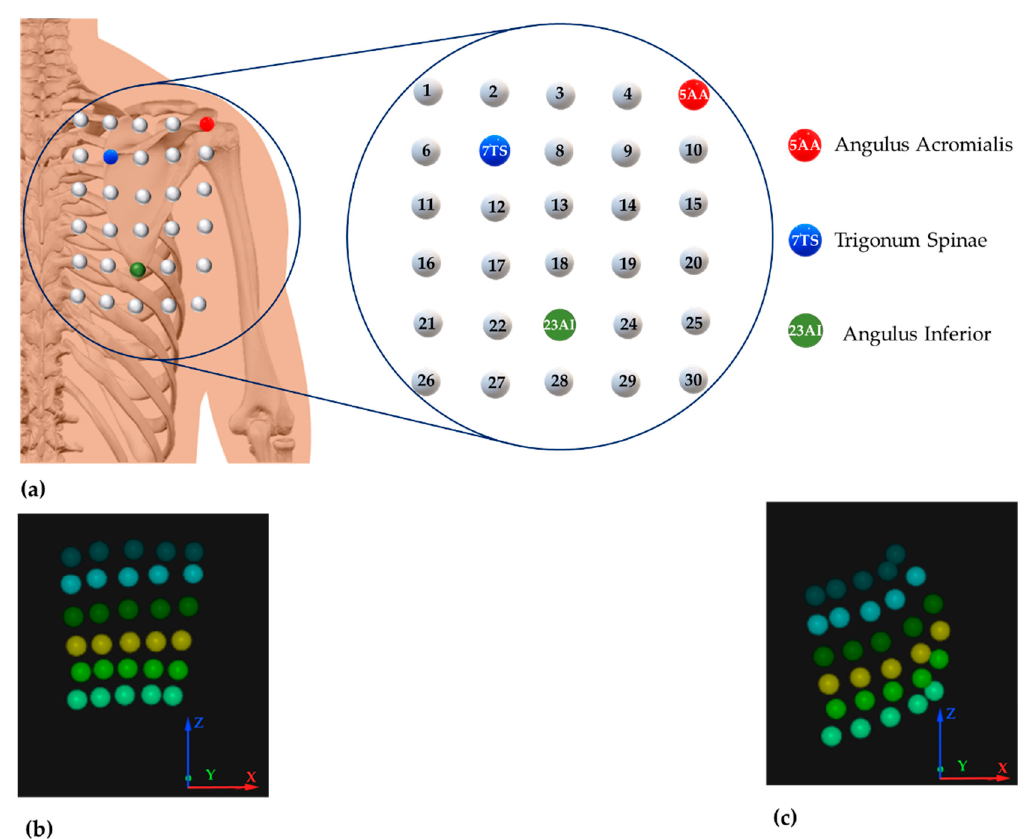
Figure 3. ( a ) Schematic representation of the 6 × 5 grid of markers positioned on the skin surface of the scapular region. ( b ) Reconstruction of the grids of markers corresponding to the starting and ( c ) elevated position.